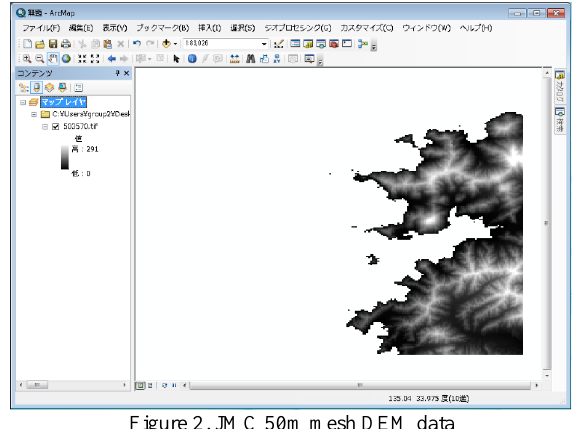
Figure 2. JMC 50m mesh DEM data